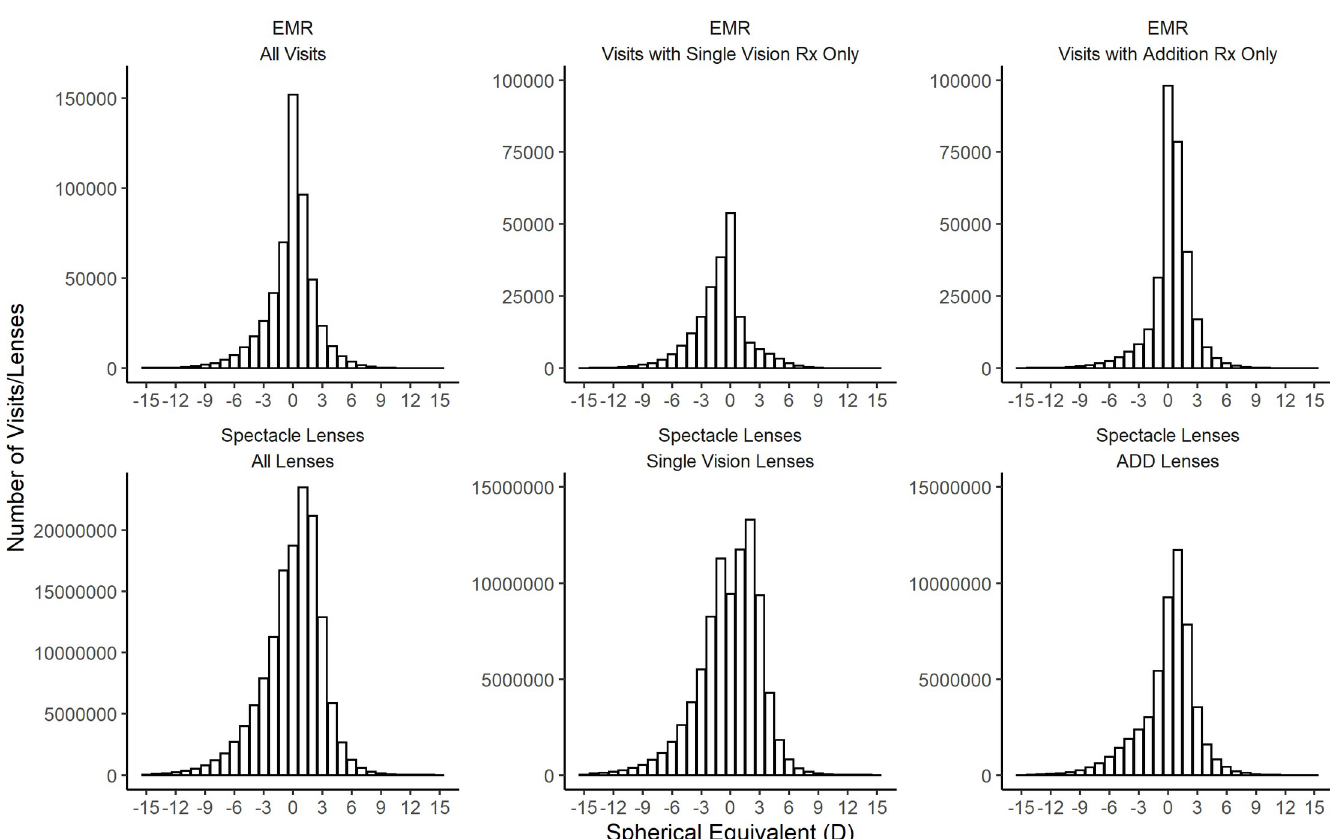
Fig 2. Distribution of spherical equivalent in each dataset. Top Panel—EMR data from Irish optometry practices. Right spherical equivalent distribution for all visits (n = 536,249), single vision prescriptions (n = 215,207) and addition prescriptions (n = 321,013). Bottom Panel—Spectacle Lens Distribution from manufacturer data for all lenses (n = 134,280,063), single vision, (SV) lenses (n = 84,561,994) and addition, (ADD) lenses (n = 49,709,191).